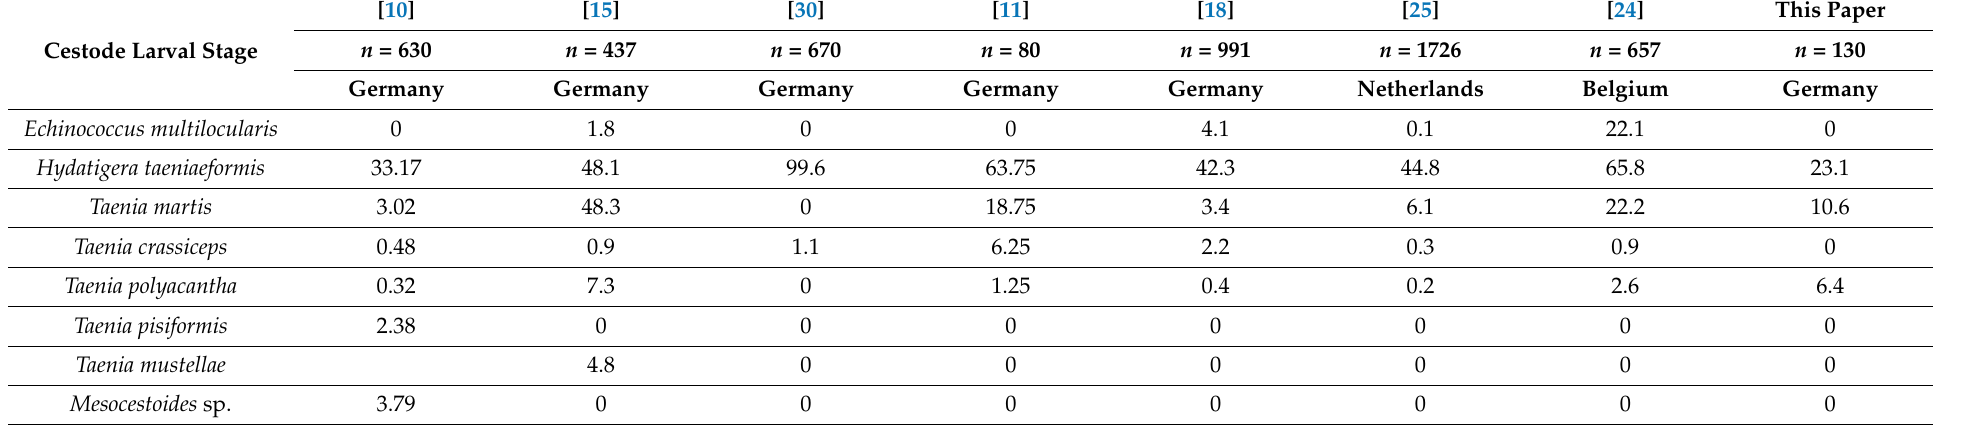
Table 4. Prevalence of cestode larval stages in muskrats in Germany, Netherlands and